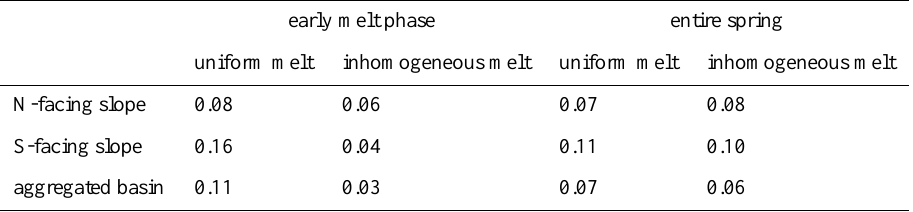
Table 3. RMS errors between simulation results and measurements of fractional snowcovered area on different slopes for both early melt phase (25 April–5 May) and the entire spring melt period. Simulations were carried out using both the uniform and inhomogeneous melt